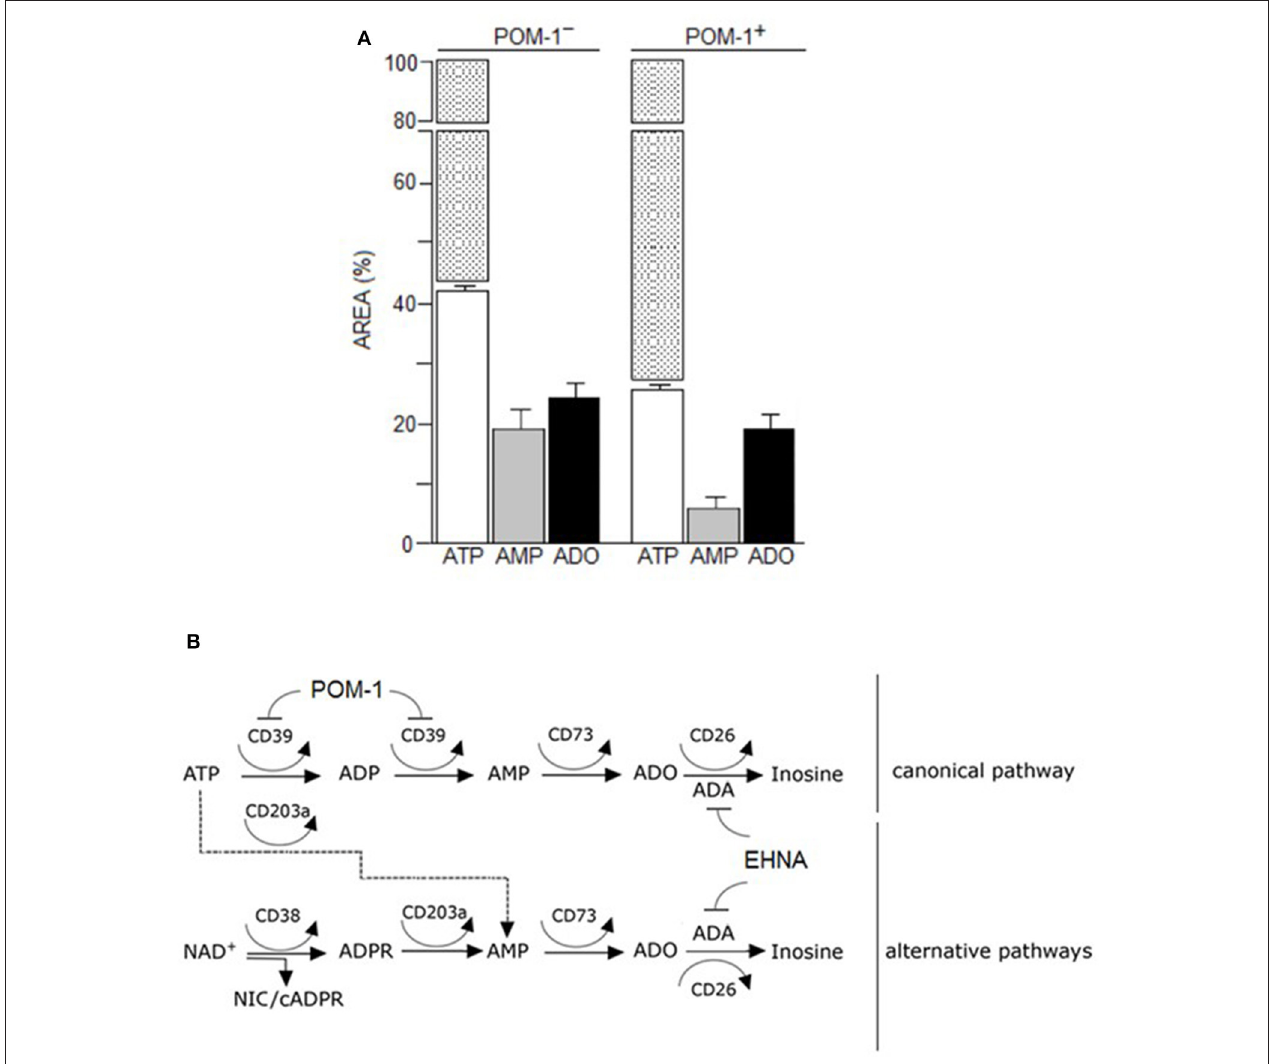
FIGURE 4 | Canonical adenosinergic pathway in CIK cells. (A) To prove the existence of ATP adenosinergic pathway in CIK cells, production of ADO was investigated in CIK supernatants collected 30min after 100 µ M ATP addition. White columns indicate the concentration of consumed ATP in the presence or absence of POM-1 (inhibitor of CD39). White/dotted columns indicate the total area of the substrate ATP (100%). Generated products (AMP and ADO) are indicated by grey and black columns, respectively. Data are expressed as area percentage (AREA %) of AMP and ADO. (B) Canonical and alternative scheme pathways of ADO production showing the enzymatic targets of POM-1 (inhibitor of CD39) and EHNA (inhibitor of adenosine deaminase,